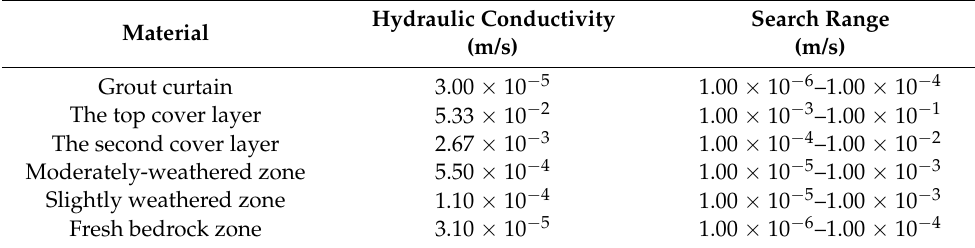
Table 4. Hydraulic conductivity of each medium determined by IGWO.